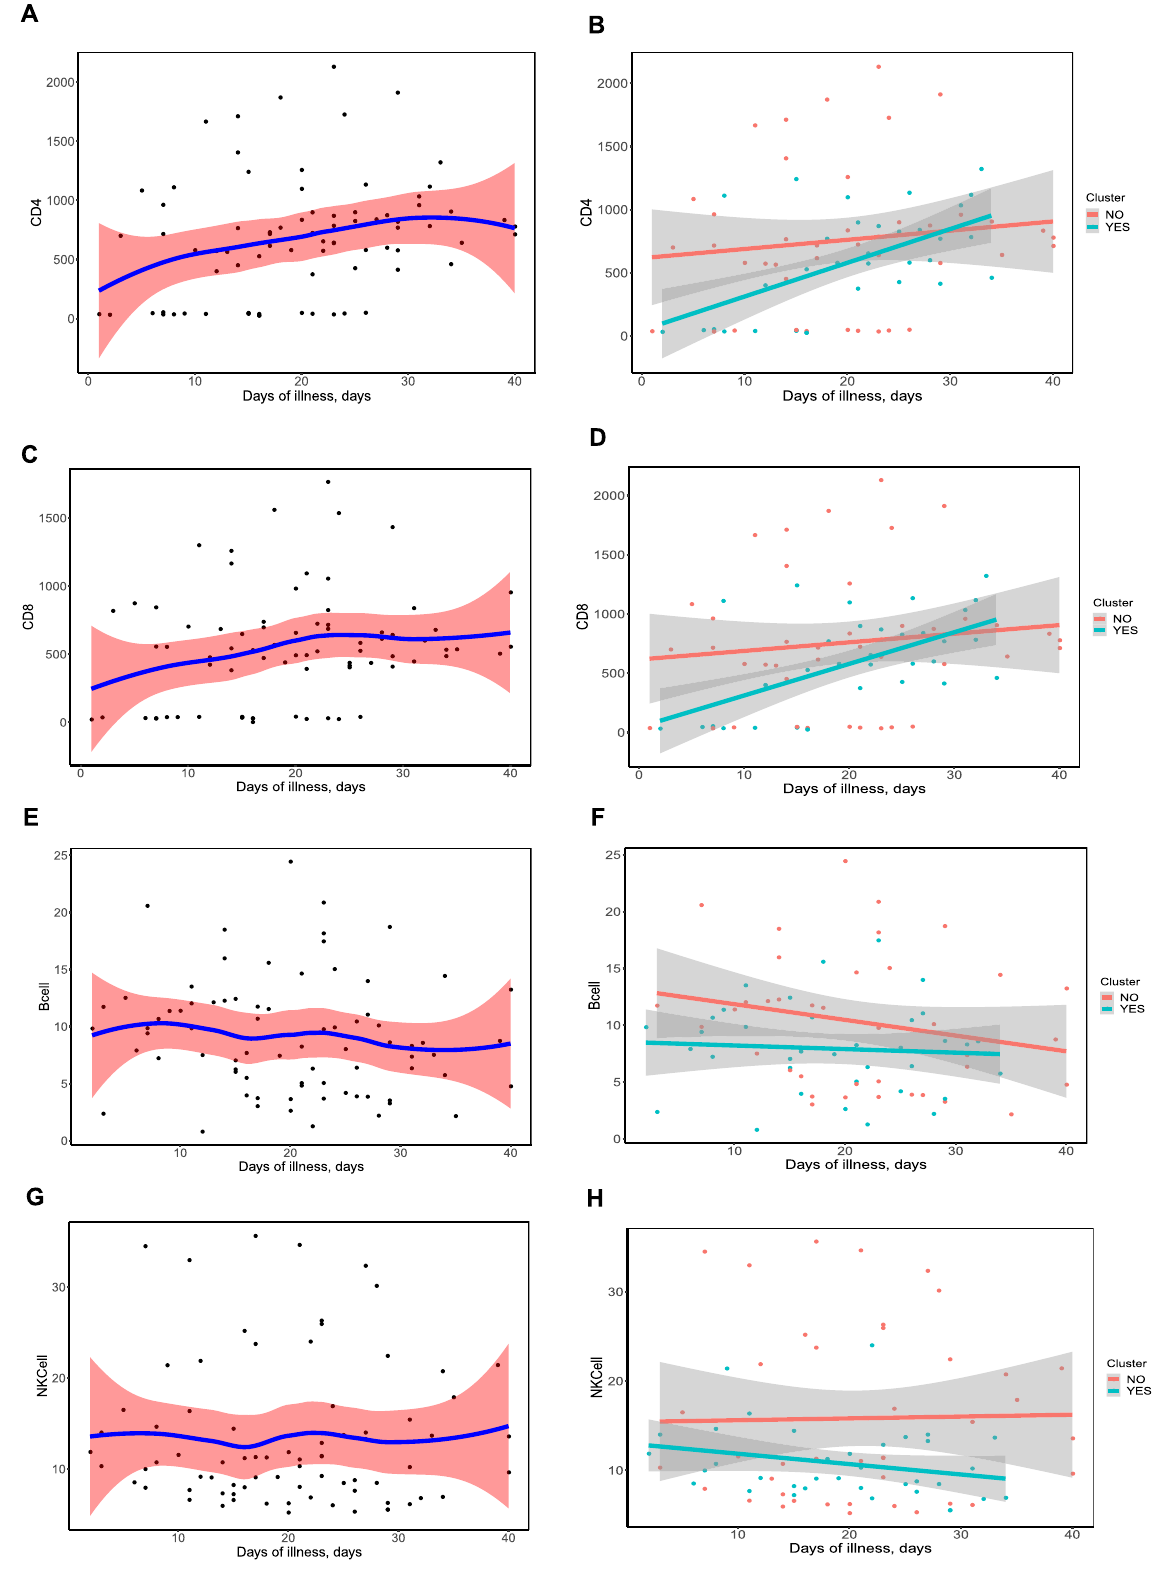
Figure 3. The smooth fit curves with 95% confident interval for the dynamic profiles of CD4, CD8, B cells and natural killer(NK) cells in all the patients ( A , C , E , G ) and the subgroup divided by family cluster ( B , D , F , H